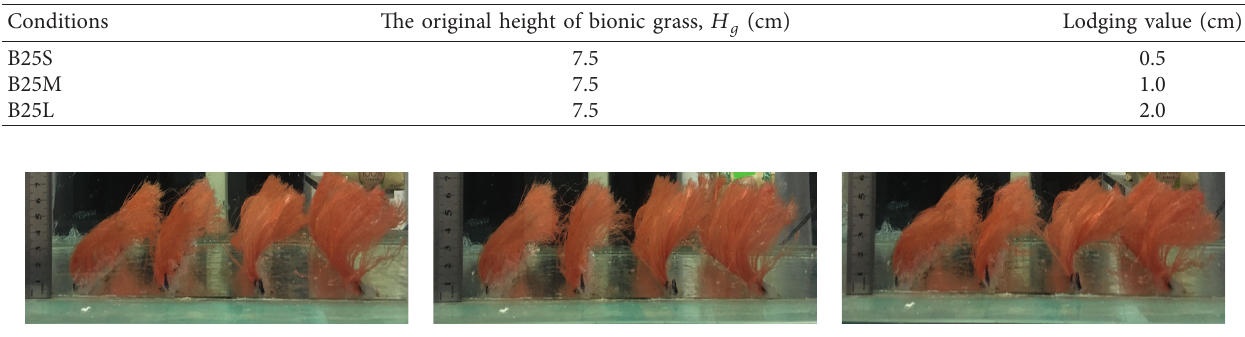
Table 2: The lodging of bionic grass under different working conditions.